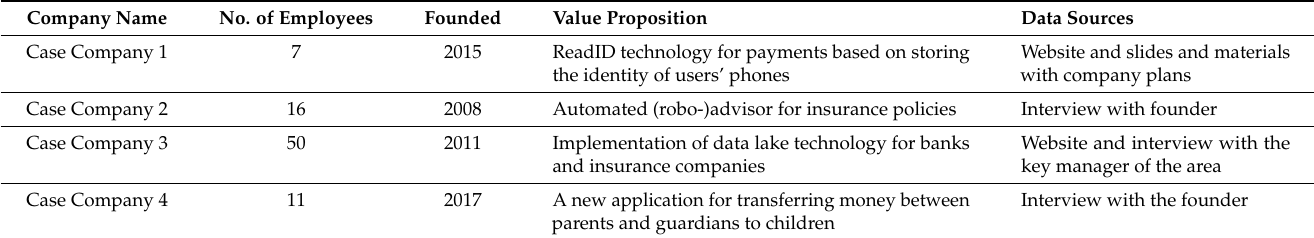
Table 1. Sample overview and data sources specified by